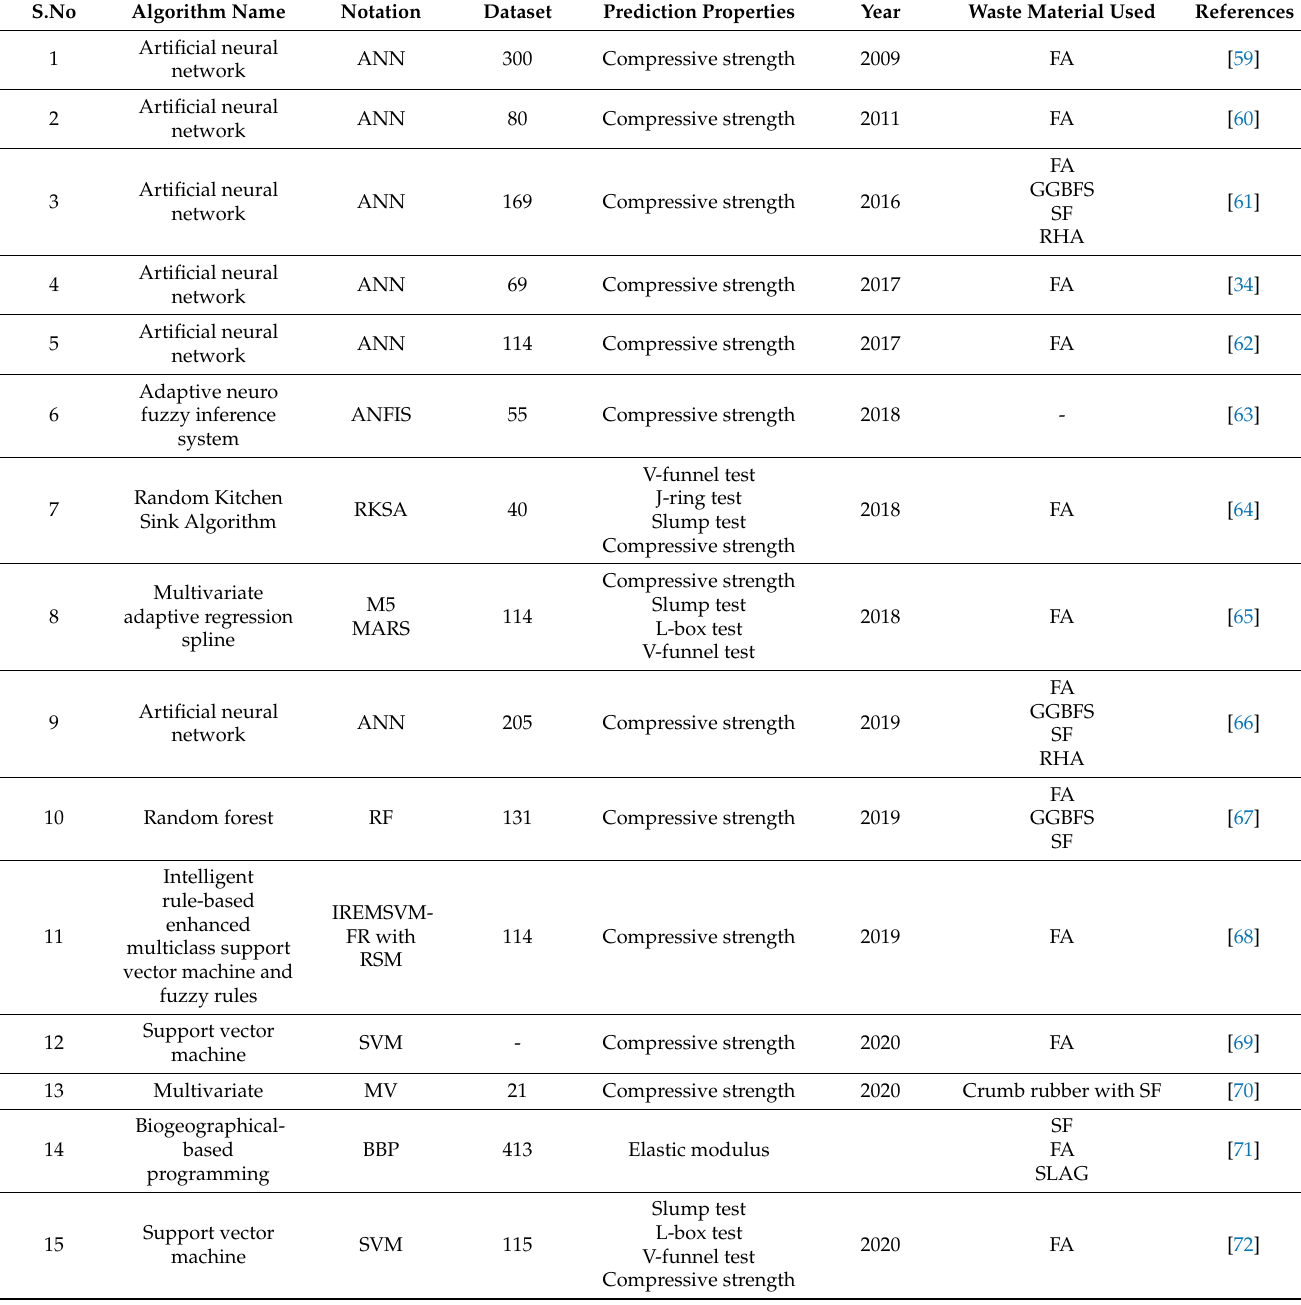
Table 1. Prediction of concrete properties by using waste